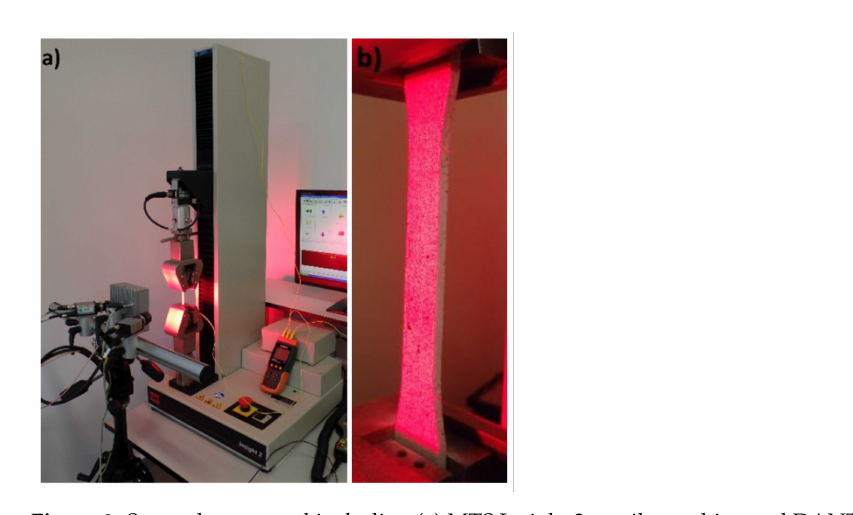
Figure 2. Strength test stand including ( a ) MTS Insight 2 tensile machine and DANTEC Q400 vision system; ( b ) grips used to fix a sample. Table 1. Results of uniaxial tensile testing of the crystalline-form samples.